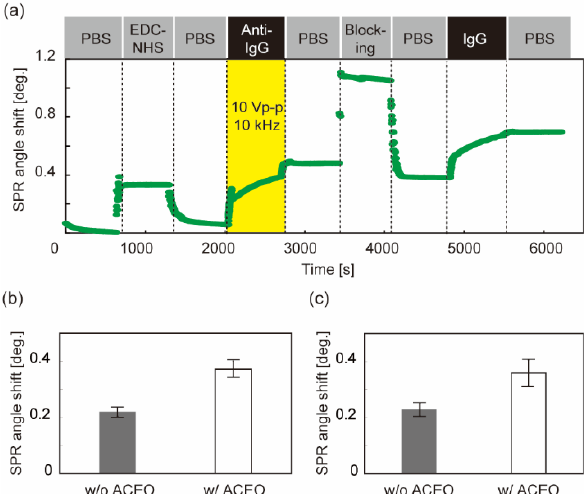
Figure 4. Detection of IgG molecules with ACEO-assisted SPR sensing. Sinusoidal voltage of 10 Vp-p and 10 kHz was applied during antibody immobilization. ( a ) SPR sensorgram (time course of the SPR angle shift) from antibody immobilization through IgG detection. The time window indicated by yellow shows the duration of voltage application. PBS: Washing process with 10 mM PBS. EDC-NHS: Immobilization of cross-linkers using EDC–NHS solution. Anti-IgG: Immobilization of antibodies that bind specifically to IgG molecules. Blocking: Application of ethanol–amine solution to block unreacted linker groups. IgG: Application of analyte (IgG). ( b ) SPR angle shift derived from the number of immobilized antibodies. ( c ) SPR angle shift derived from the analyte bindings. N = 4. Error bars show the standard deviation.